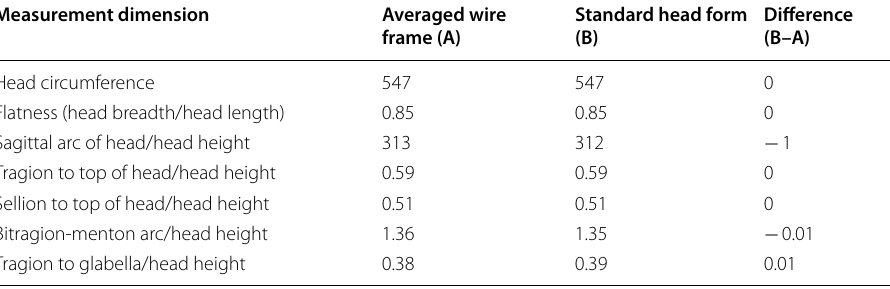
Table 10 Error verification of standard head form and averaged wire frame (unit: mm) Measurement dimension Averaged wire